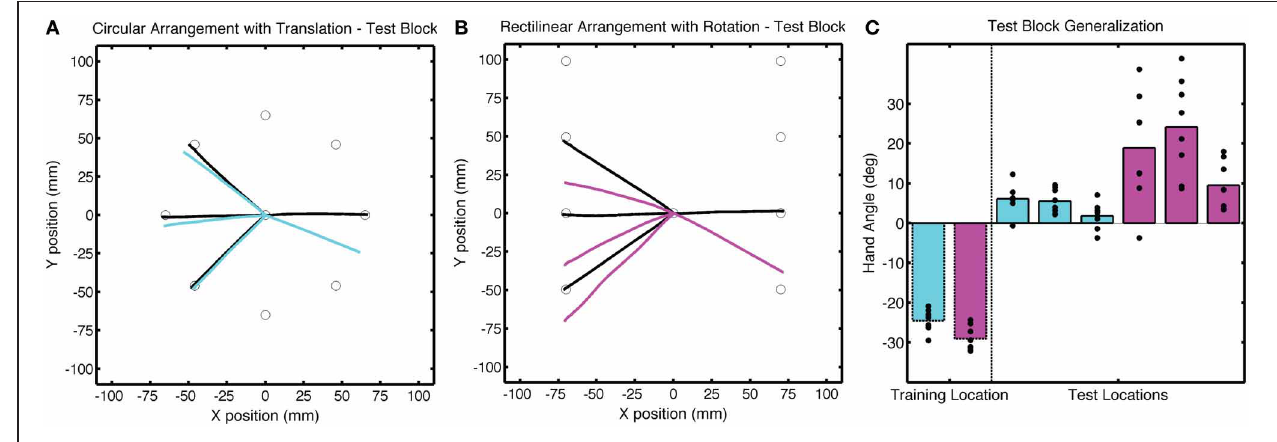
during the last baseline block (black). (C) Mean endpoint hand angles for the training location and three probe target locations (135 ◦ , 180 ◦ , and − 135 ◦ ). Black circles represent the values for each participant.